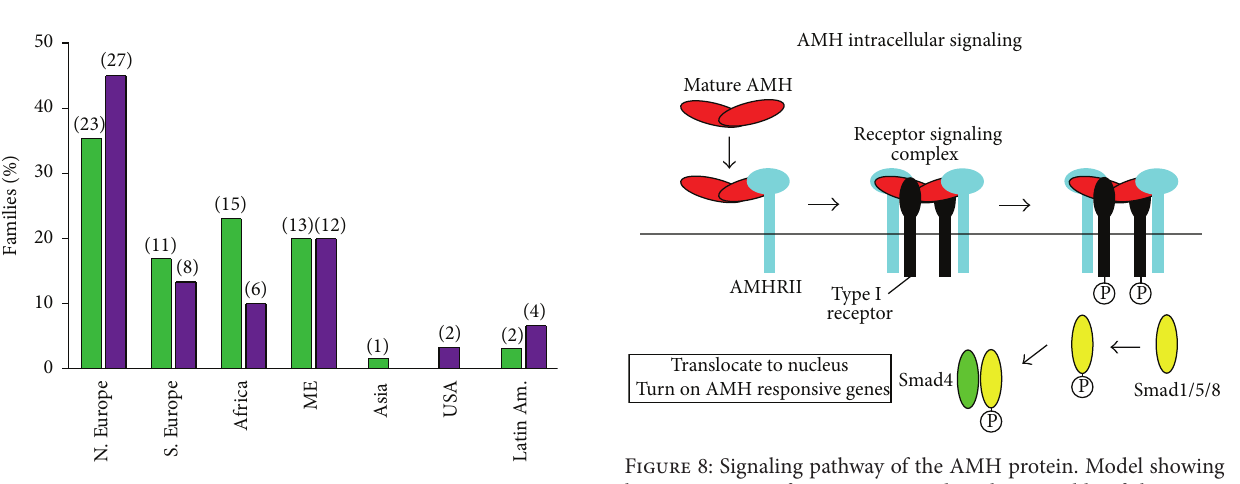
Figure 8: Signaling pathway of the AMH protein. Model showing how processing of AMH may regulate the assembly of the recep- tor signaling complex. Cleavage of full-length AMH results in a conformational change in the C-terminal domain, indicated by the shape and color change, which allows binding of AMRH-II. Binding of AMHRII induces dissociation of the proregion via a negative allosteric interaction between the receptor- and proregion-binding sitesontheC-terminaldimer,indicatedbytheshapechange.Results presented in this paper are consistent with proregion dissociation occurring before type I receptor engagement, but this has not been proven.TypeIandIIreceptor-bindingsitesontheC-terminaldimer are indicated by either a I or a II; black labels indicate sites on the front of the dimer, and white labels indicate sites on the back of the dimer. From [2], Copyright The Endocrine Society, 2010, with